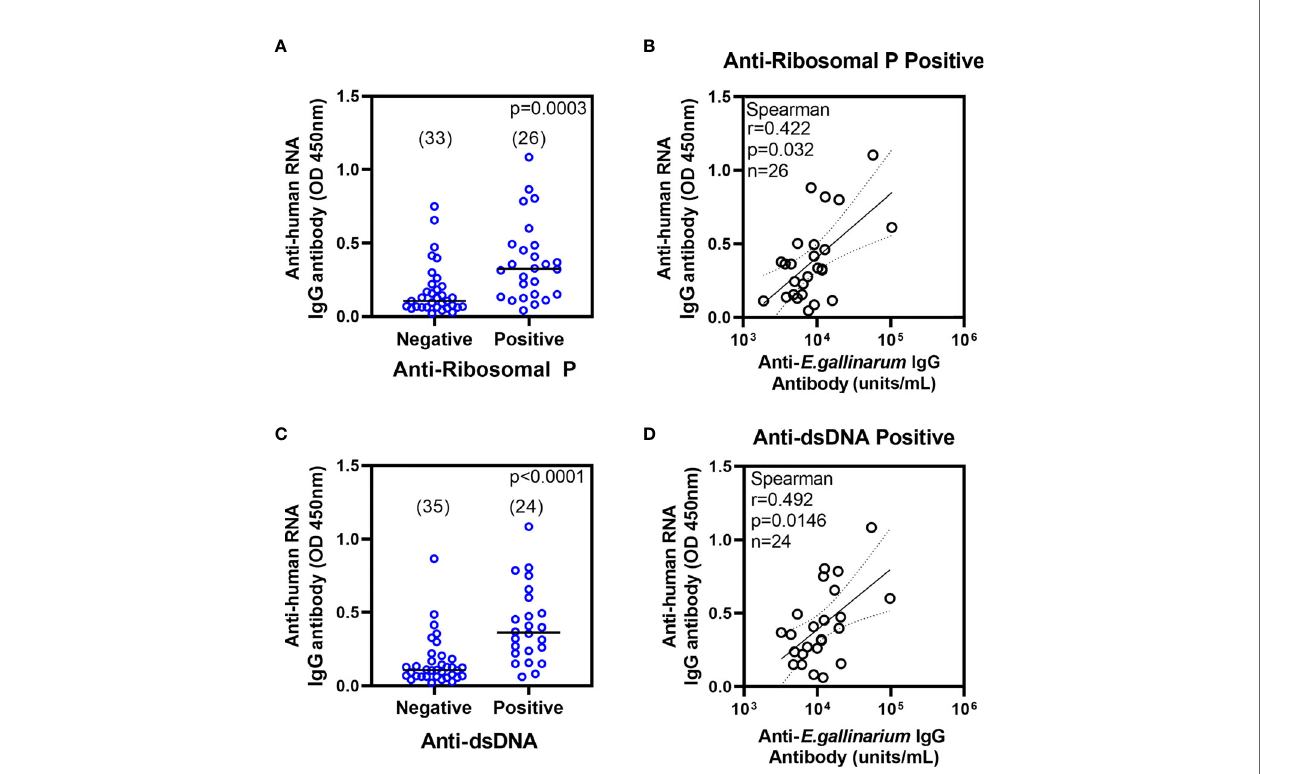
FIGURE 3 | Anti-human RNA IgG antibodies in anti-Ribosomal P (A) and anti-dsDNA (C) negative and positive patients. All samples were tested at a 1:100 serum dilution and results are shown as absorbance at 450nm. Antibody levels were compared using non-parametric Mann-Whitney test. Number of samples are shown in parentheses. Correlation between anti-human RNA IgG and anti- Eg IgG titers in patients positive for anti-Ribosomal P (B) and anti-dsDNA (D) . OD, optical